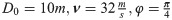
COV-IO: Agent velocity and tangent of vertical viewing angle velocity, initial conditions D0=10m,ν=32ms,φ=π4.